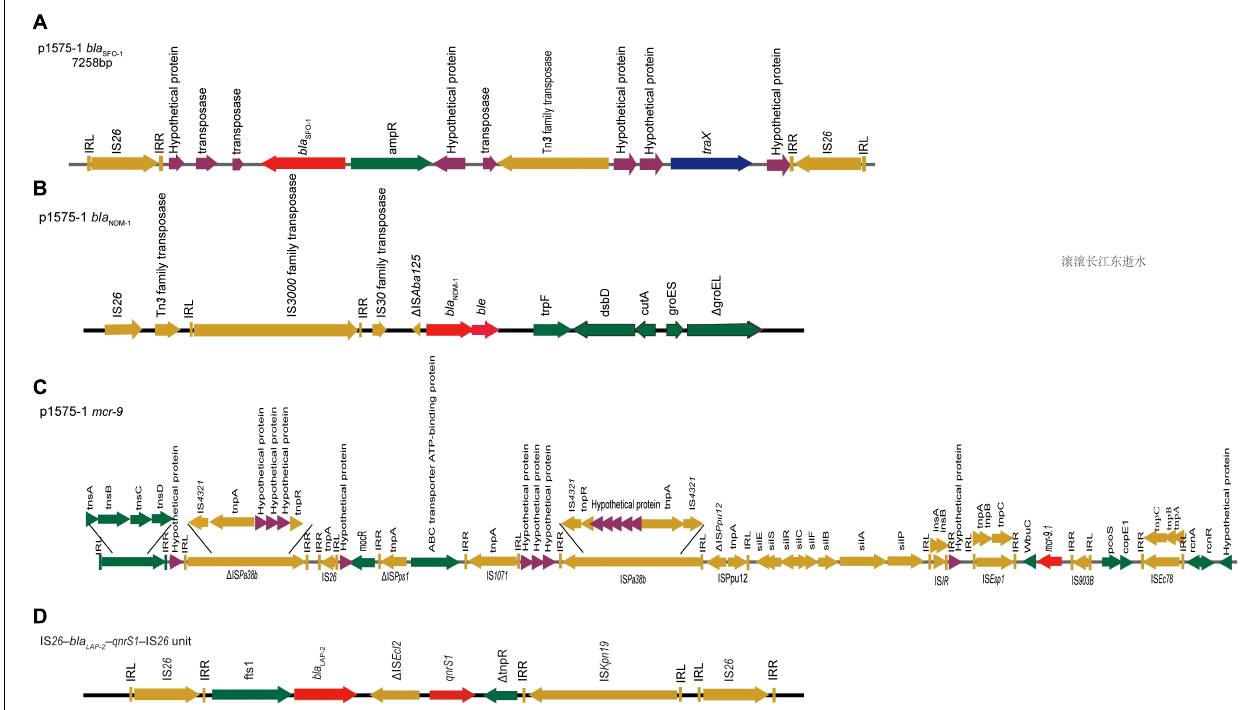
FIGURE 3 | bla SFO − 1 , bla NDM − 1 , and mcr-9 gene contigs. Genetic environments surrounding the bla NDM − 1 , bla SFO − 1 and mcr-9 genes in plasmid p1575-1. (A) The DNA fragments flanking the bla SFO − 1 gene in plasmid p1575-1. (B) The DNA fragments flanking the bla NDM − 1 gene in plasmid p1575-1. (C) The DNA fragments flanking the mcr-9 gene in plasmid p1575-1. (D) The IS 26 – bla LAP − 2 – qnrS1 –IS 26 module. Colored arrows indicate open reading frames, with dark green, dark yellow, dark blue, purple, and red arrows representing other genes, mobile and accessory elements, the individual conjugation-related genes, hypothetical proteins and transposases, and antibiotic resistance genes,